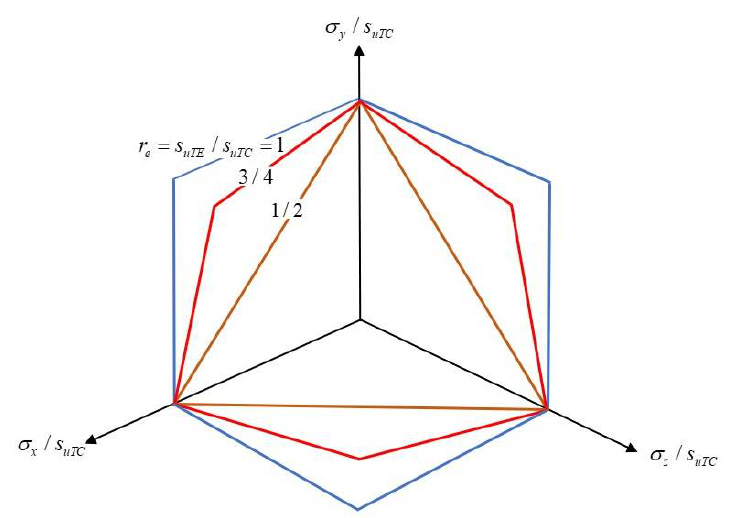
Figure 2. Generalized Tresca surface used in the Anisotropic Undrained Shear (AUS) failure criterion.